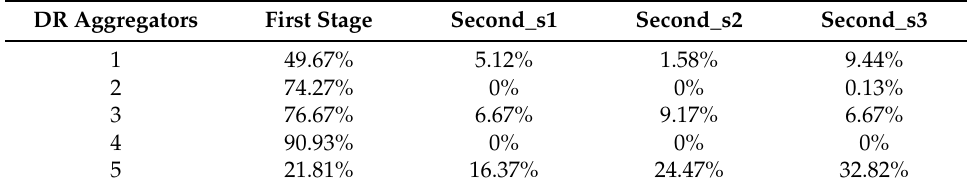
Table 8. Average absolute proportion of DR scheduled in each stage for each aggregator: With transmission